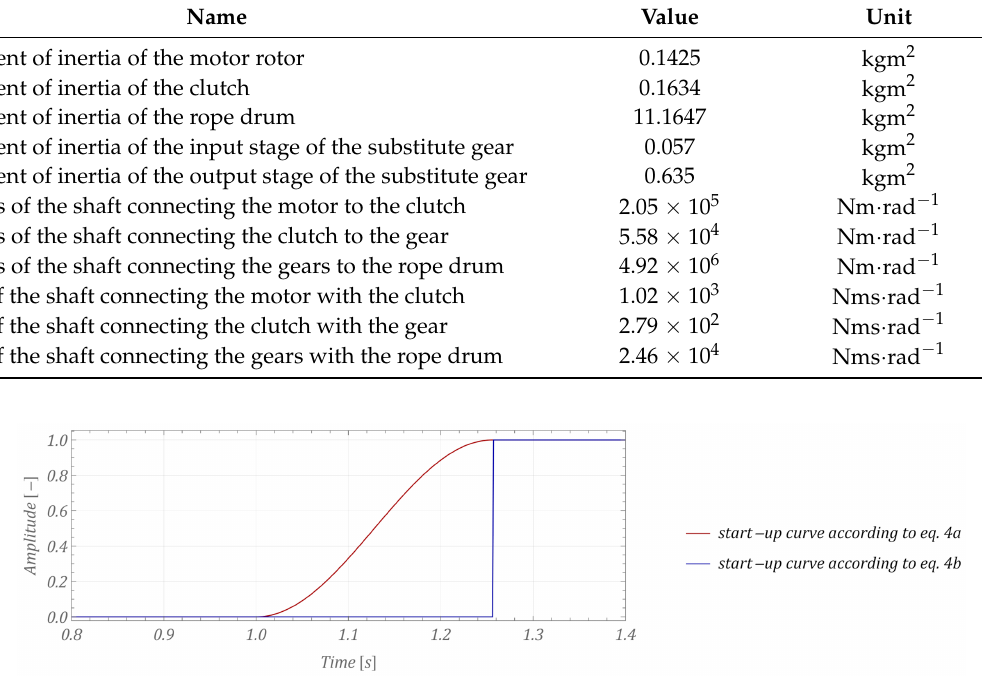
Figure 4. Sample excitation